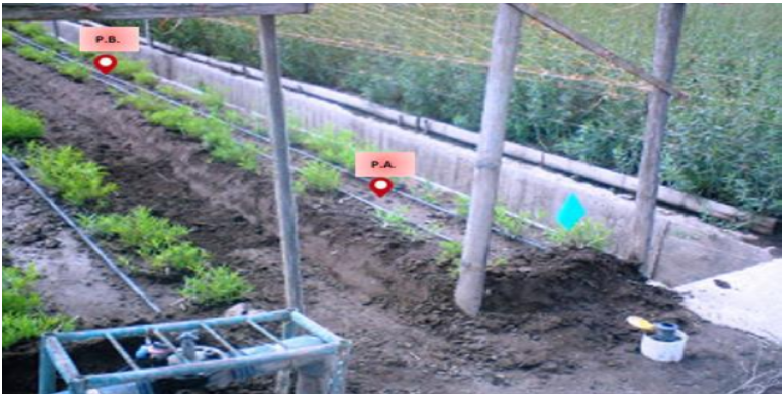
Figure 9. Sub-mark acquisition inside the greenhouse